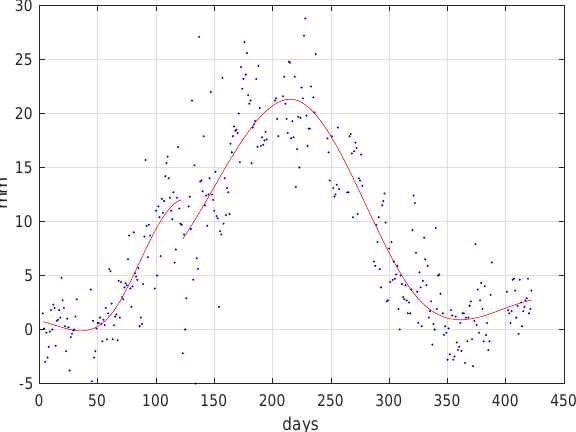
Figure 13. East point time series, Up component. Observed values (blue dots) and model (red